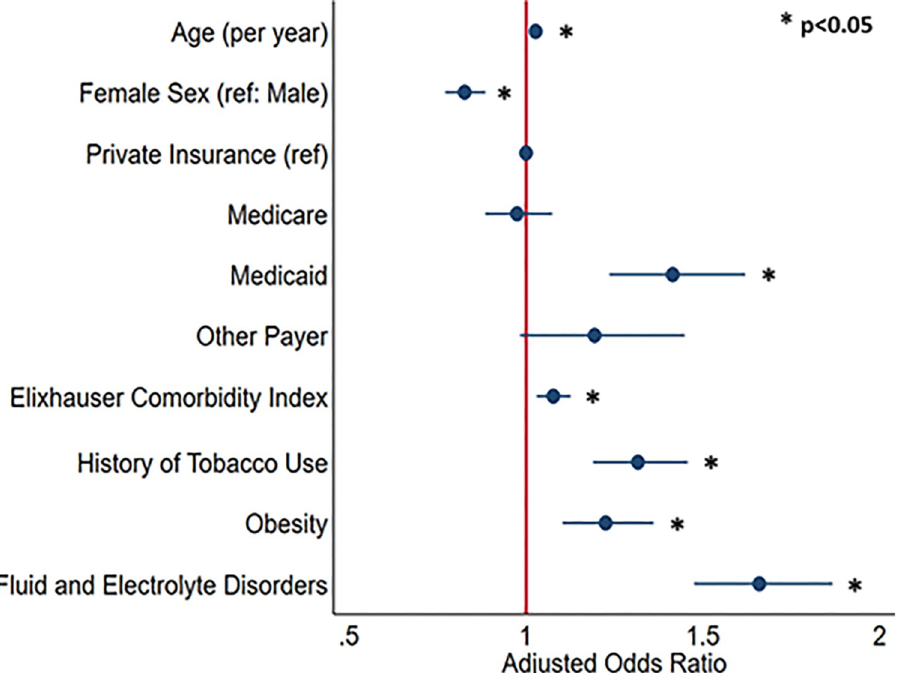
Fig 2. Patient characteristics associated with risk of conversion to open following intended minimally invasive colectomy.